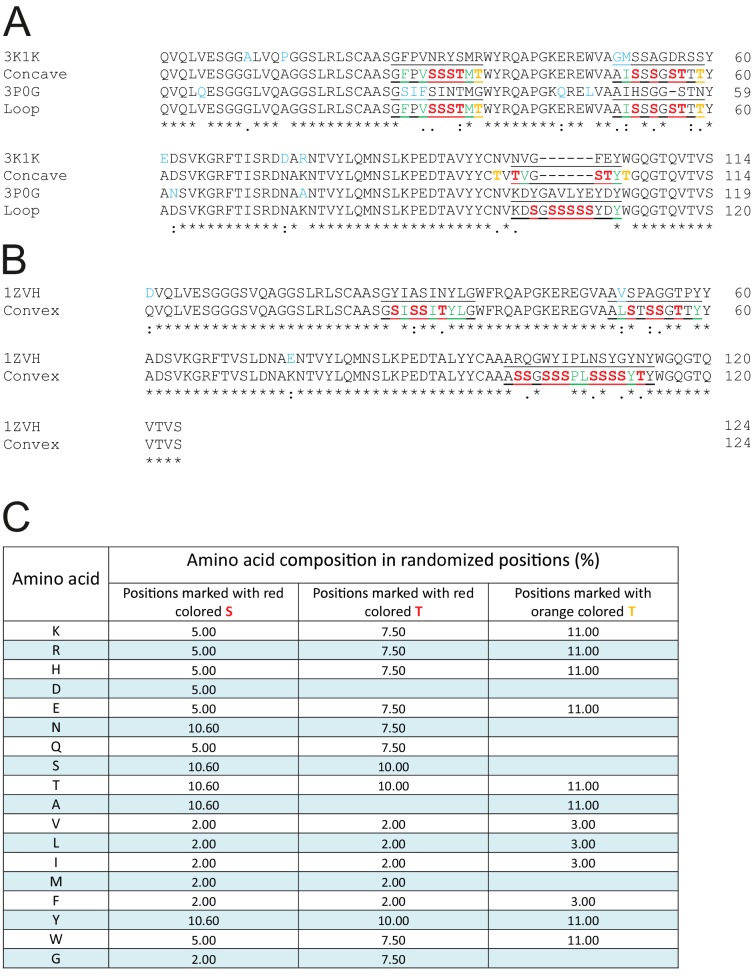
Framework sequences and randomized positions.(A and B) Sequences of the framework sybodies are aligned with the sequences of their natural precursors. The frameworks of the concave and the loop library are identical (A) while the convex library has its own scaffold (B). Residues of the natural precursor nanobodies differing from the framework sequence are marked in blue. The three CDR regions are underlined. Invariant CDR residues contributing to the hydrophobic core of the respective scaffold are marked in green. Note that the differently shaped libraries exhibit alternative sets of invariant CDR residues that precisely match the corresponding scaffolds. This harmonization is a critical and unprecedented feature of our synthetic nanobdy libraries, as it allows for the first time to include variable CDR lengths without the risk of scaffold destabilization. Randomized residues are highlighted as red S (for which randomization mixture one was used), as red T (mix 2) and orange T (mix 3). (C) Amino acid composition of randomized positions obtained by three different trinucleotide randomization mixtures. The rationale behind the three randomization mixtures is provided in the main text.